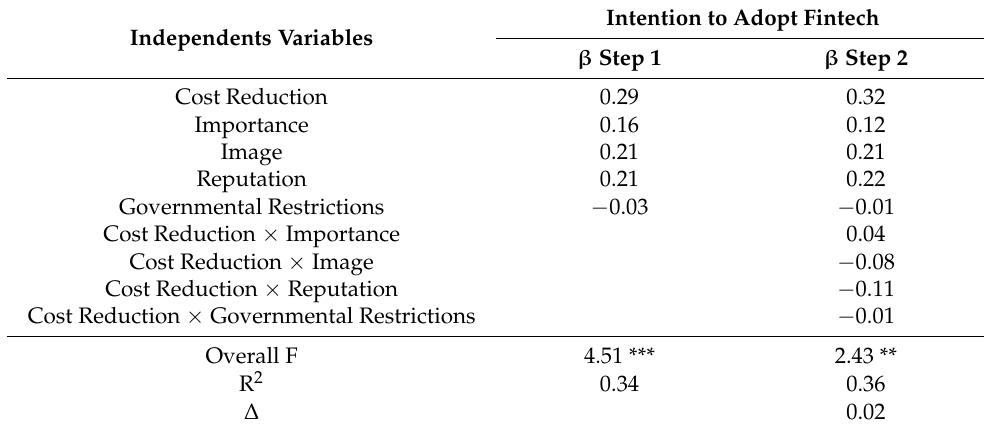
Table 7. Moderating effect of environmental context on the relationship between cost reduction